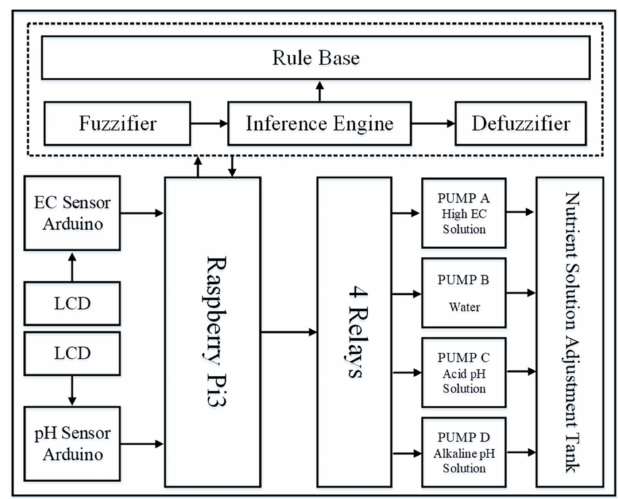
Figure 1. System architecture.